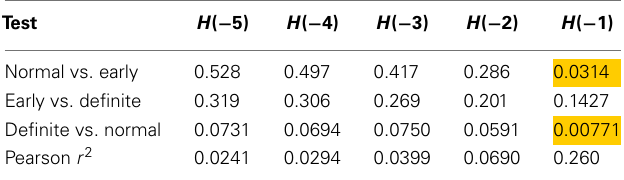
Table 4 | Results of Mann–Whitney tests for Renyi entropy calculated with negative exponents and using method 7 .